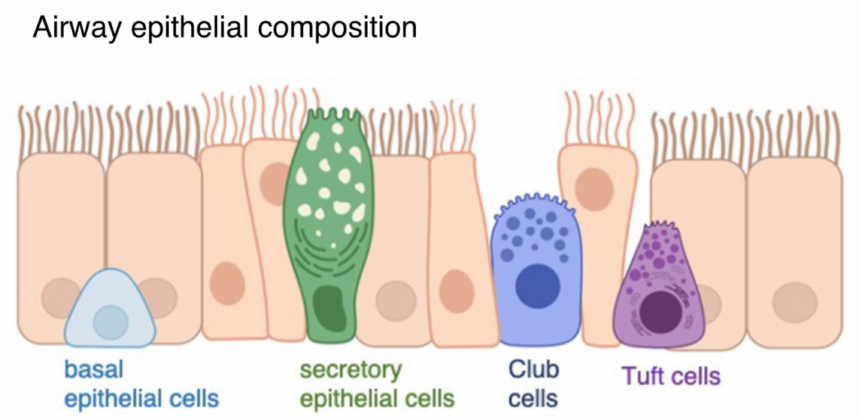
Figure 1. Airway epithelial composition. The airway epithelium consists of ciliated cells (orange), basal epithelial cells (light blue), secretory epithelial cells (green), Club cells (dark blue) and tuft cells